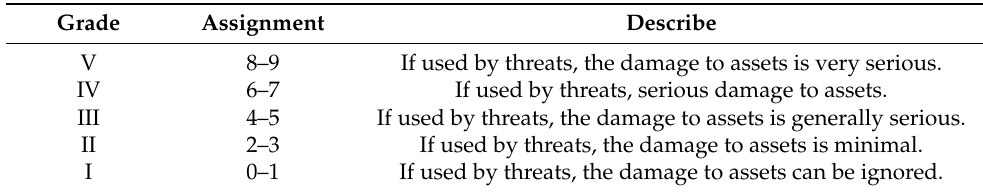
Table 2. Vulnerability level.